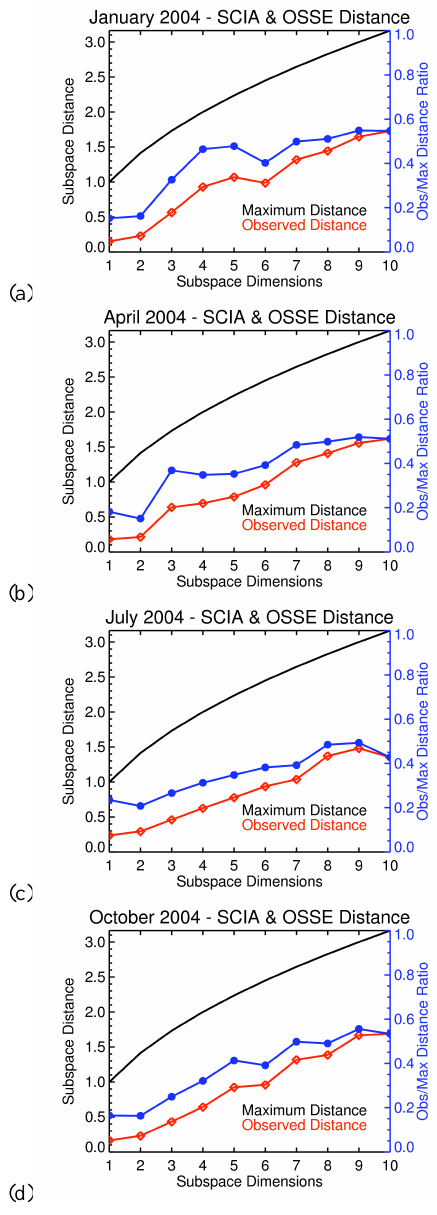
Fig. 7. The observed subspace distances between the SCIAMACHY and OSSE reflectance subspaces for ten subspaces (red) compared to the maximum possible distance between the two subspaces (black). The blue line shows the ratio between the observed sub- space distance and the maximum possible distance for each number of subspace dimensions, that is, the ratio of the values on the red line to the values on the black